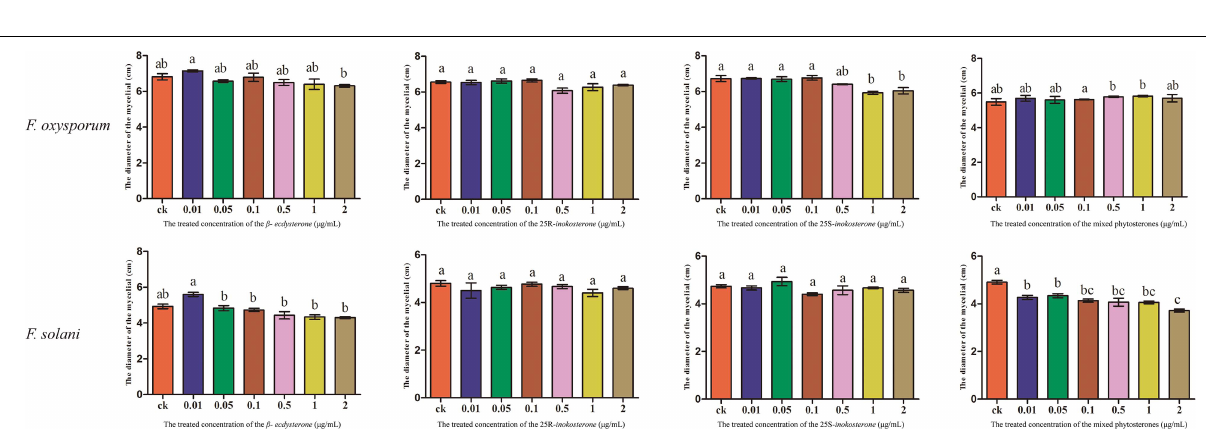
Frontiers in Microbiology |